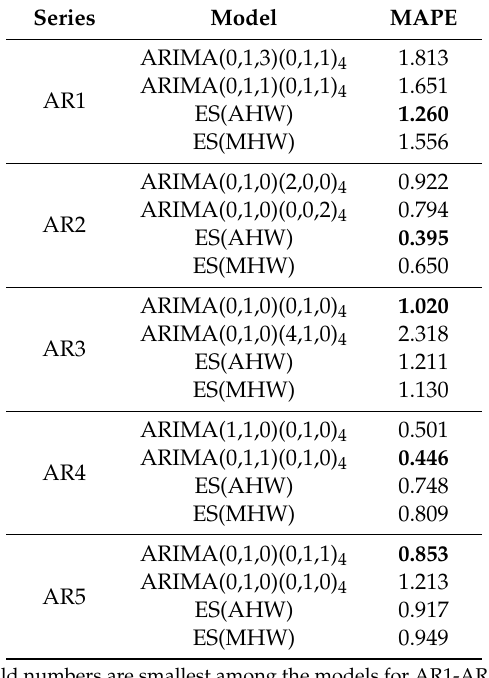
Table 9. Forecast values for building cost of one-storey house in New